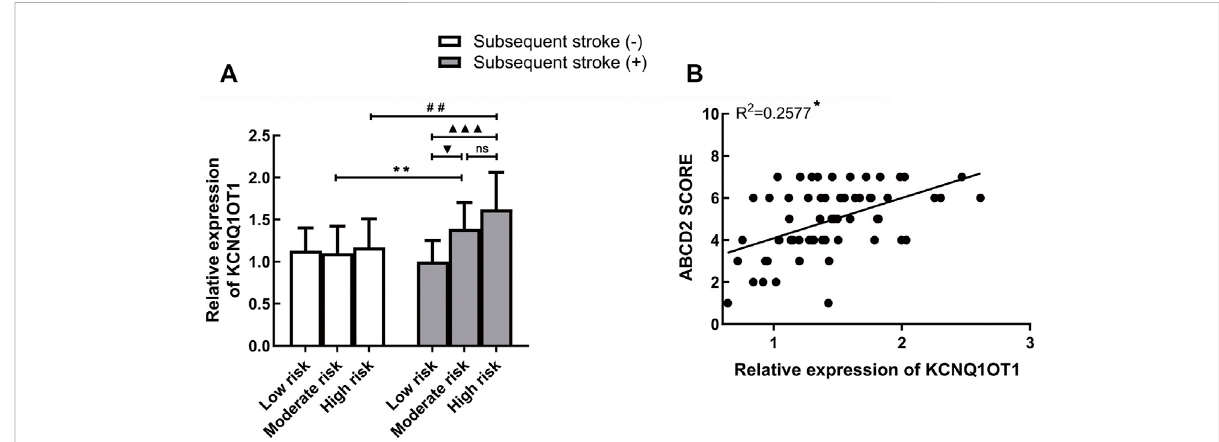
FIGURE 2 KCNQ1OT1wasassociatedwithrisklevelsofTIA. (A) KCNQ1OT1wasincreasedsigni fi cantlyinsubsequentstroke-positivecasesatmoderateor high risk. * p < 0.05 vs. subsequent stroke (+) group at moderate risk . # p < 0.05 vs. subsequent stroke (+) group at high risk. (B) Expression of KCNQ1OT1 was positively associated with the ABCD2 score in TIA patients with subsequent stroke events ( n = 65, * p < 0.05).